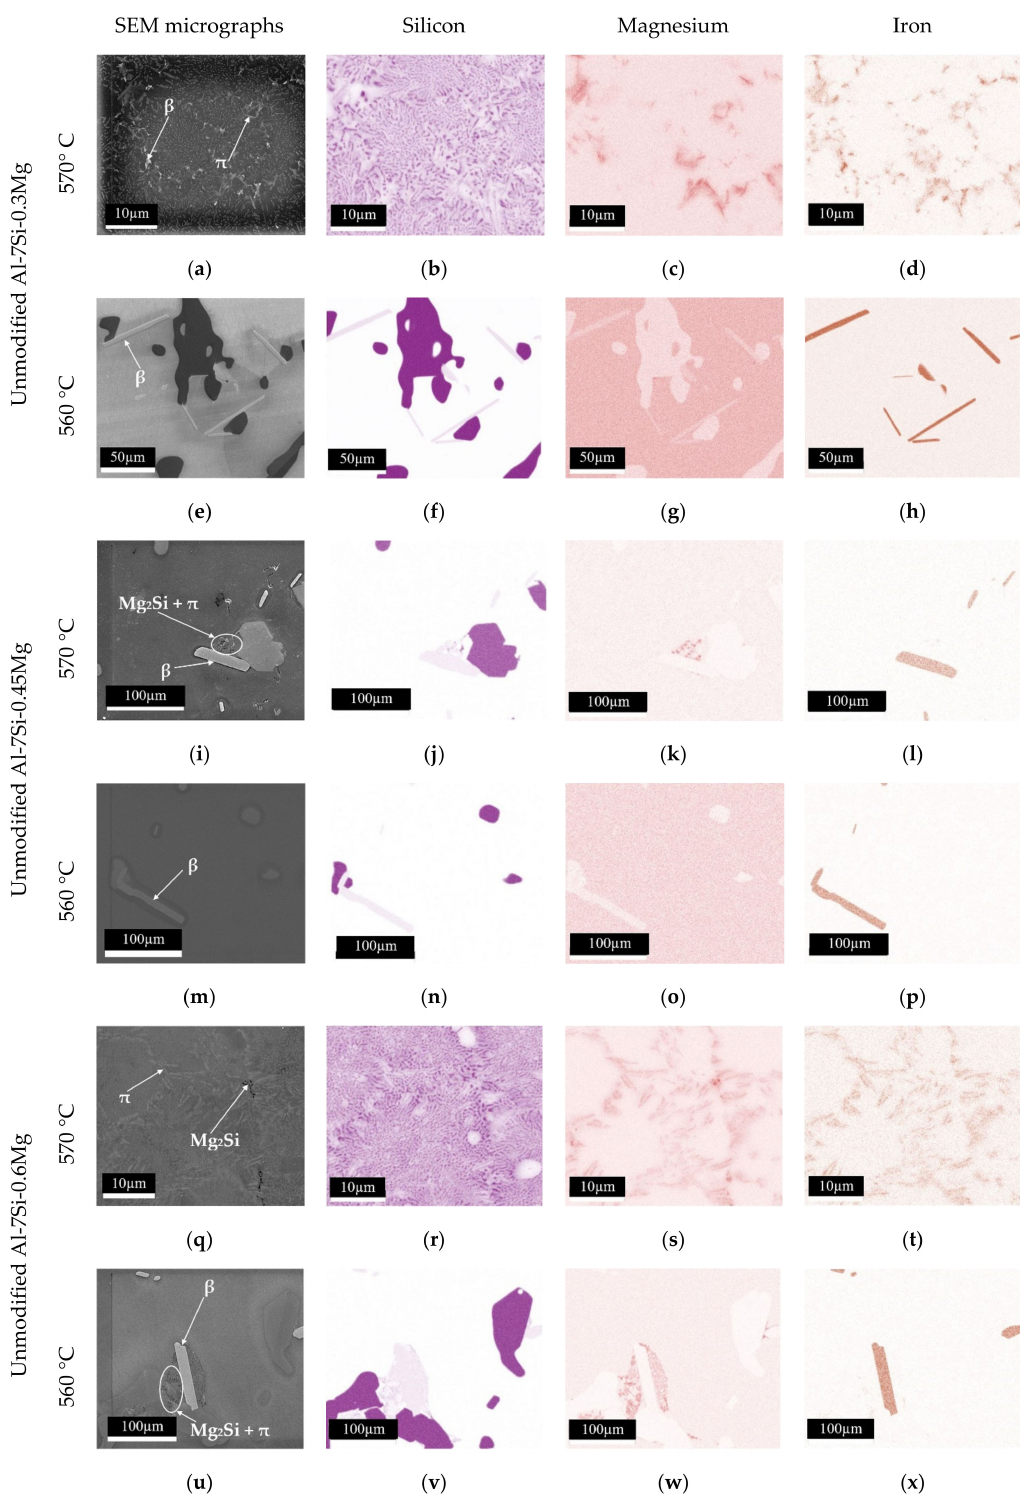
Figure 5. Scanning Electron Microscope (SEM) micrographs and respective Energy-dispersive X-ray Spectroscopy (EDS) mapping showing silicon, magnesium and iron distribution of unmodified Al-7Si-Mg alloys, isothermally held at 560 ◦ C and 570 ◦ C: ( a–h ) Al-7Si-0.3Mg, ( i–p ) Al-7Si-0.45Mg, ( q–x ) Al-7Si-0.6Mg (Color figure